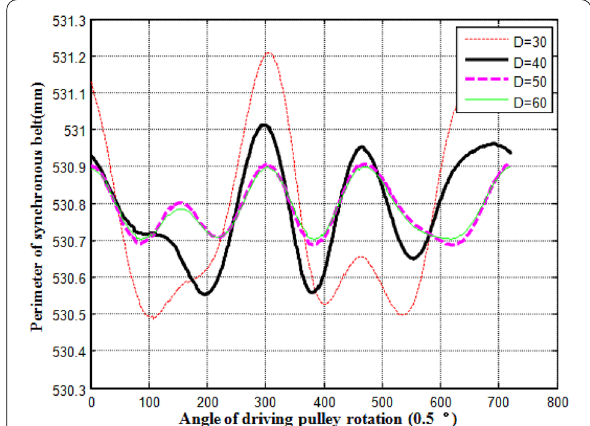
Figure 15 Band length variation curve corresponding to different directional diameters